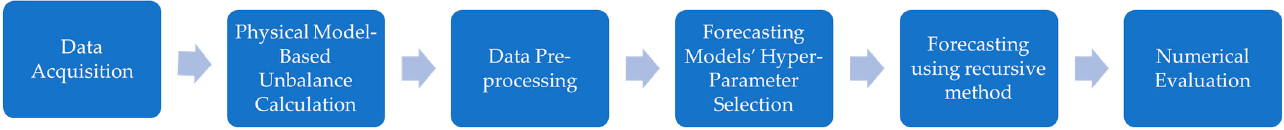
Figure 3. Schematic of forecasting